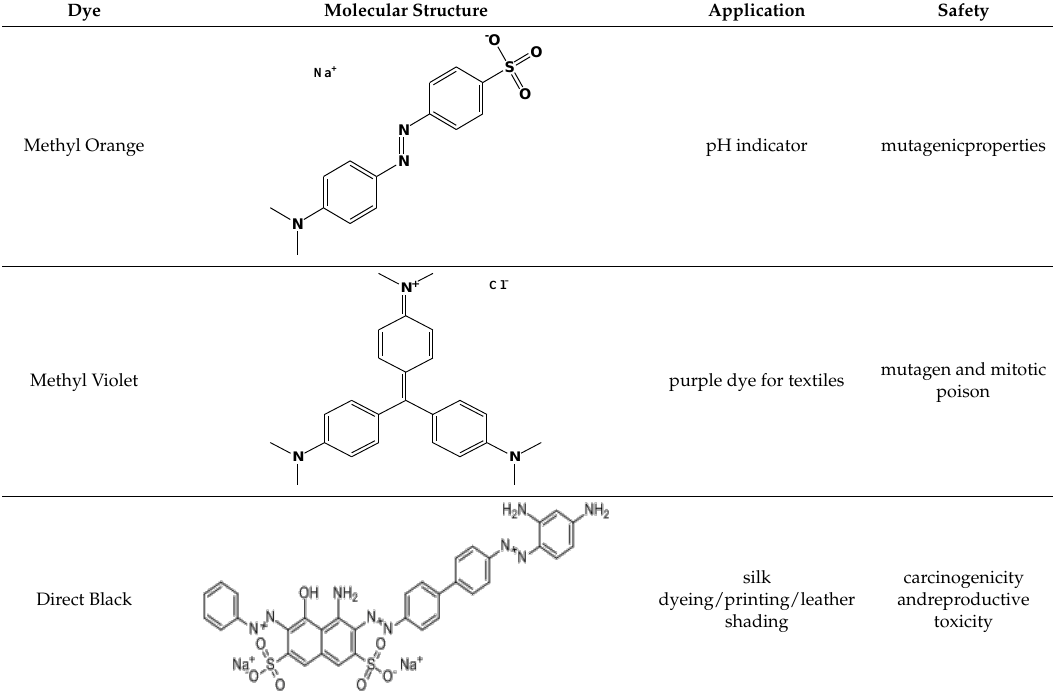
Figure A1. Cycling runs in the photocatalytic degradation of MO with BiOI/BiOCl as the photocatalyst under visible light irradiation. Table A1. Molecular structures and characteristics of the dyes.